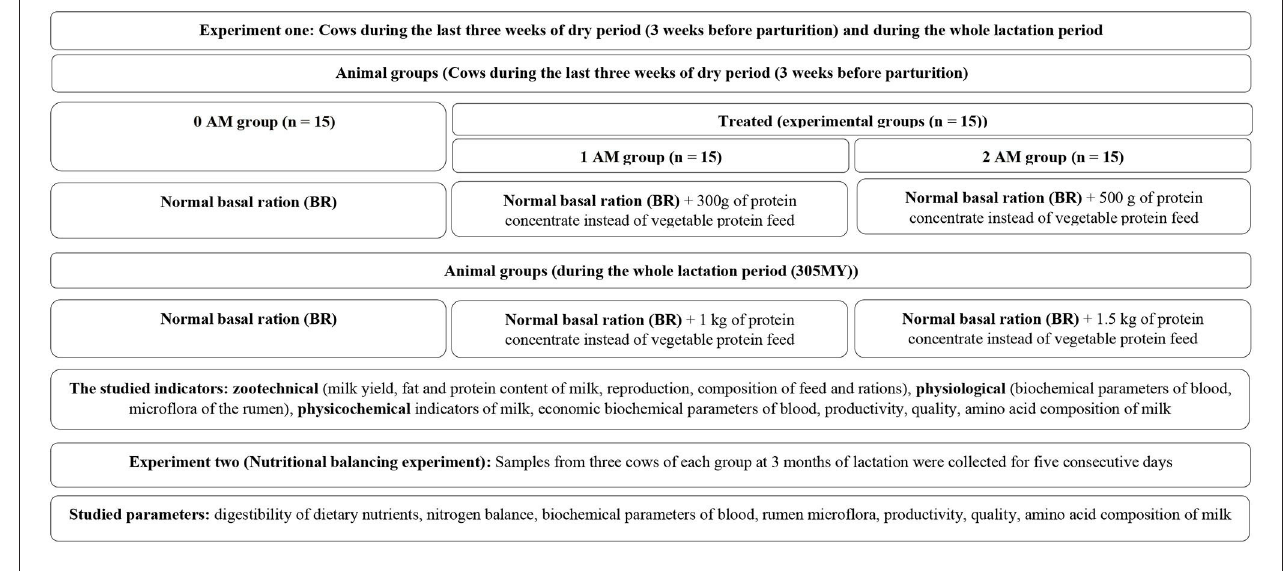
FIGURE 1 | Experimental diagram.